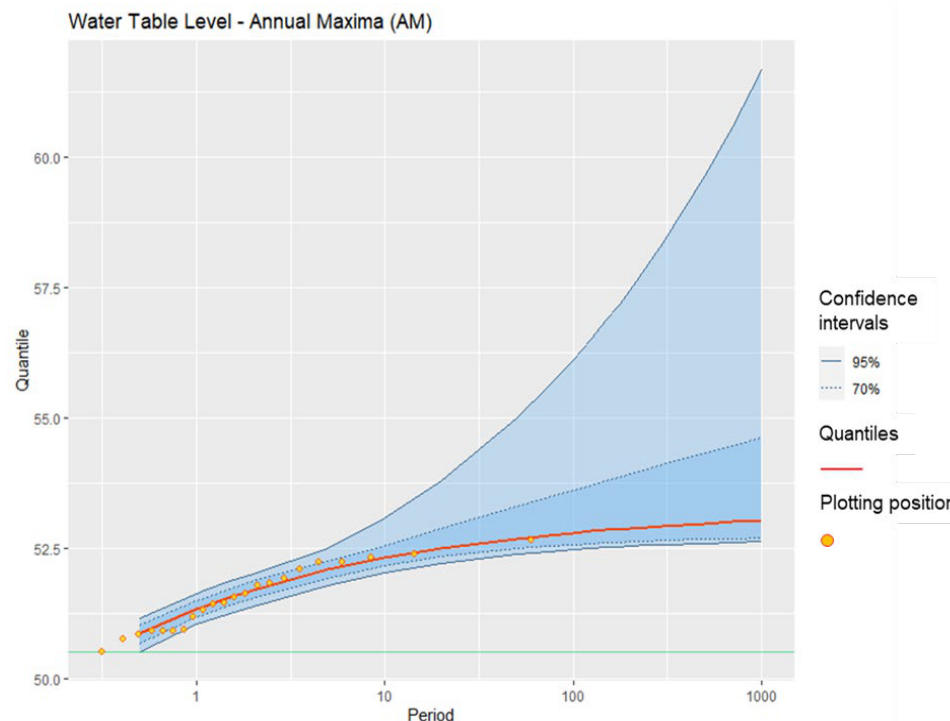
Figure 5. Quantiles and confidence intervals of GWT levels.